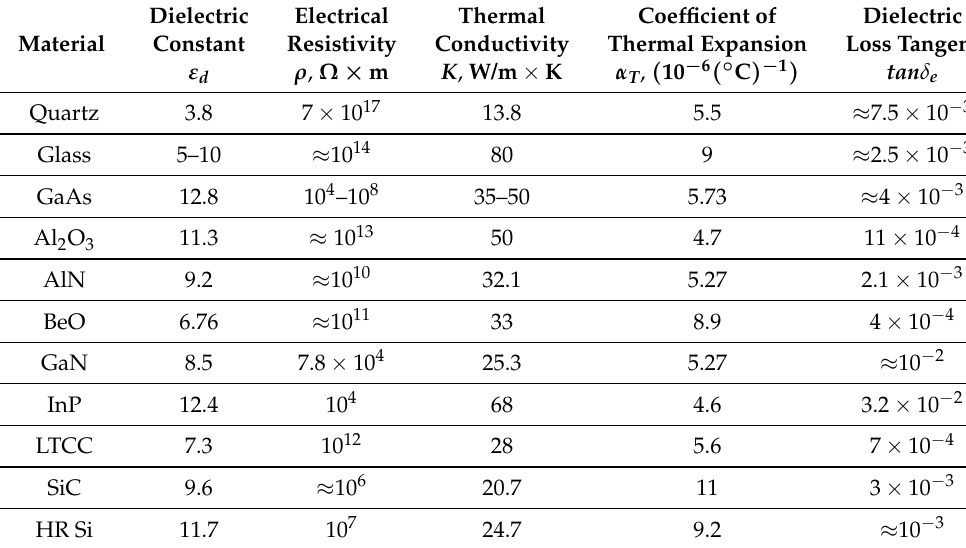
Table 2. The main parameters for choosing the material of the substrate. Dielectric Electrical Thermal Coefficient of Dielectric Material Constant Resistivity Conductivity Thermal Expansion Loss